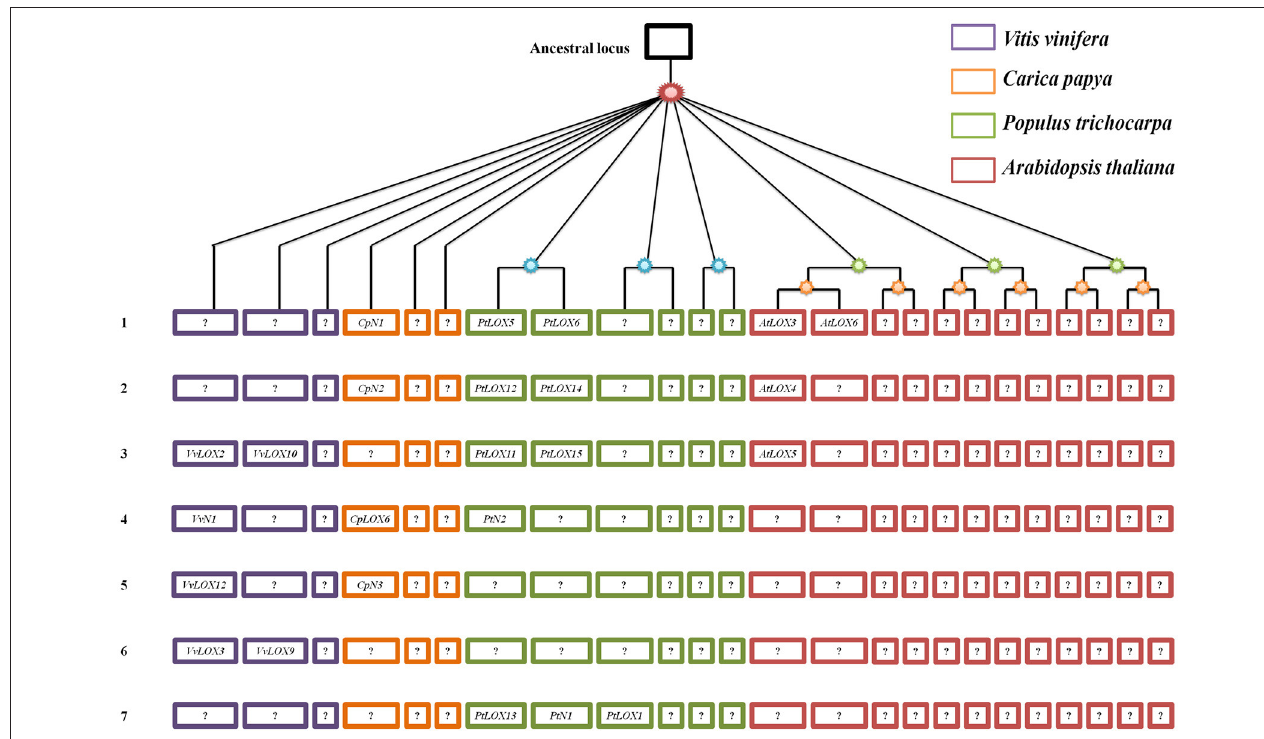
FIGURE 8 | Panoramic picture to visualize the differential retention and expansion of the ancestral LOX s associated with paleopolyploidy events that have occurred in four modern rosids. Square represents a SCB duplicated through paleopolyploidy events within and between species. Codes in the square correspond to associated LOX genes. Genes in the same line are thought to have originated from the same ancestral gene. Genes coded with an “N” between the letter and the number (e.g., CN1) represent those that have sub-functionalized into non-LOX; blank positions correspond to situations where the whole SCBs has been completely